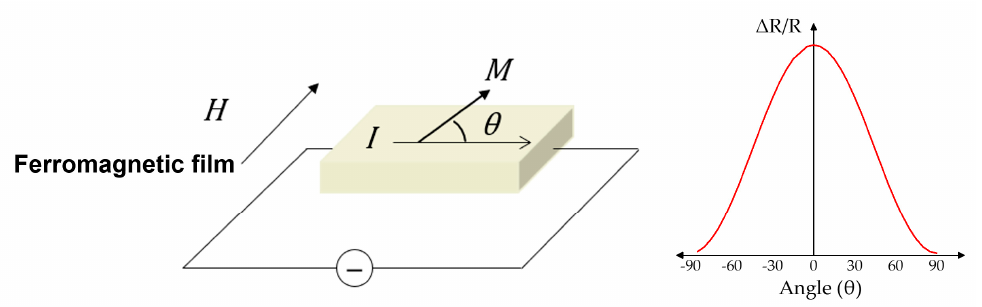
Figure 3. Working principles of AMR sensor.